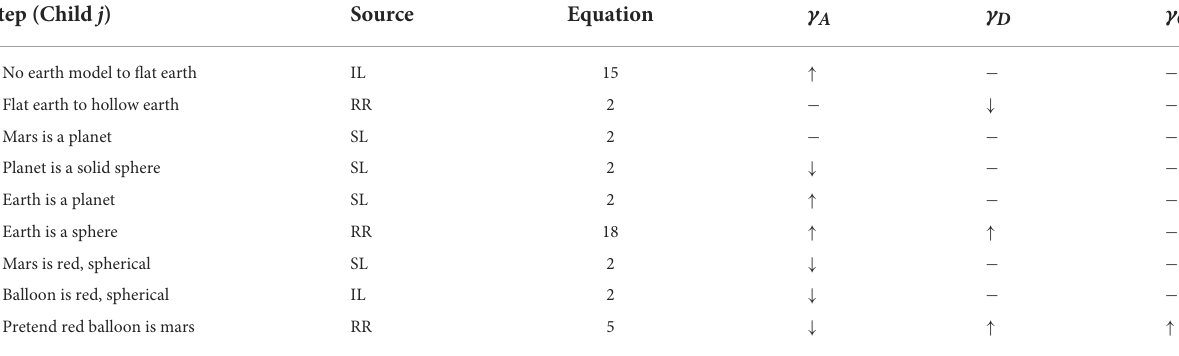
TABLE 6 Conceptual change in child j , and source of change, i.e., whether a given transition was due to individual learning (IL), social learning (SL), or representational redescription (RR) resulting in a new mental representation. Step (Child j